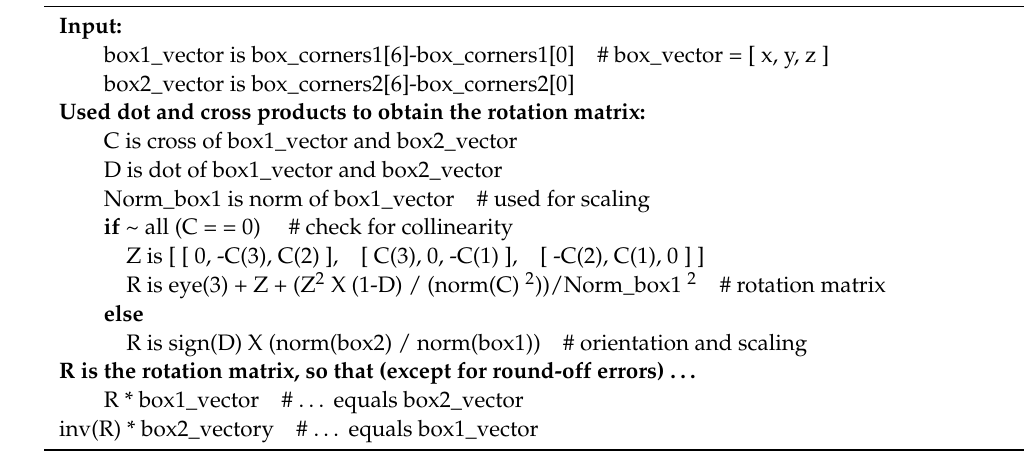
Algorithm 2 Calculated rotation matrix between two box 3D vectors